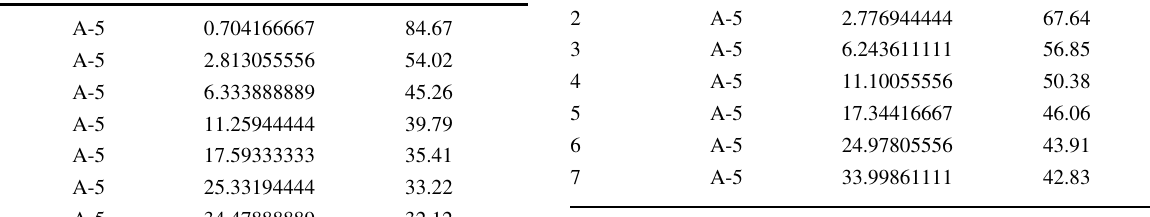
Table 6 Capillary pressure vs water saturation Lab Data S